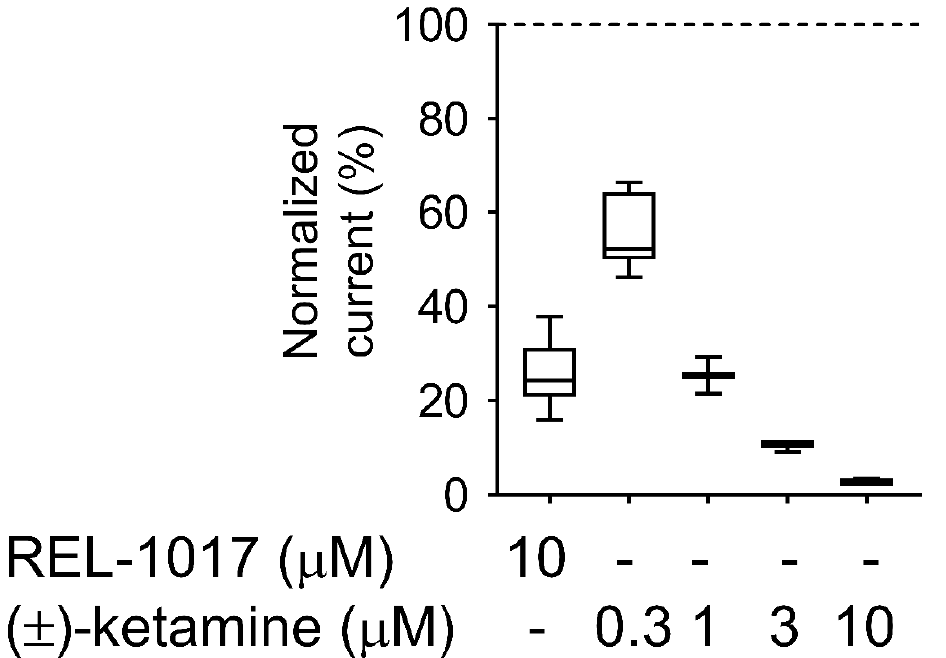
Figure 4. Experiments were conducted using whole-cell patch-clamp electrophysiology at a − 70 mV holding potential. Concentrations of ( ± )-ketamine able to inhibit 75% of the current elicited by 10 µM glutamate and glycine each were applied to a cell line expressing heterodimeric NR1-2C NMDARs to carry out kinetic studies. These experiments showed that 10 µM REL-1017 and 1 µM (±)-ketamine elicited similar current blockade of approximately 75%. Control current (100%) was induced by 10 µM L-glutamate and 10 µM glycine, respectively, and resulted in -594.2 ± 103.7 pA (mean ± SEM, n = 28). 10 µM REL-1017 and 10 µM, 3 µM, 1 µM, and 0.3 µM (±)-ketamine reduced